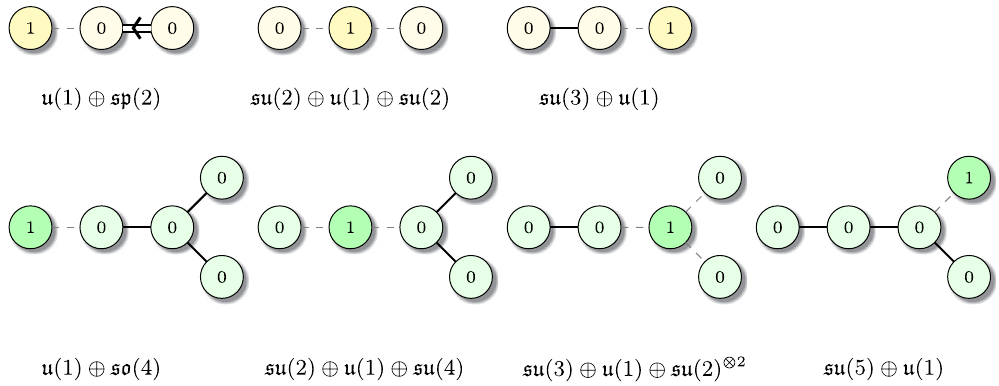
FIG. 3. Various symmetry-breaking patterns in fundamental ferromagnets with on-site irreducible representations V ω Lie algebras C 4 ¼ sp ð 4 Þ (top) and D 5 ¼ so ð 10 Þ (bottom). The vacuum stability subgroup H always includes a U(1) factor. The n th Dynkin node with label 1 corresponds to the a th fundamental irreducible representation with highest weight Λ ¼ ω designate the broken